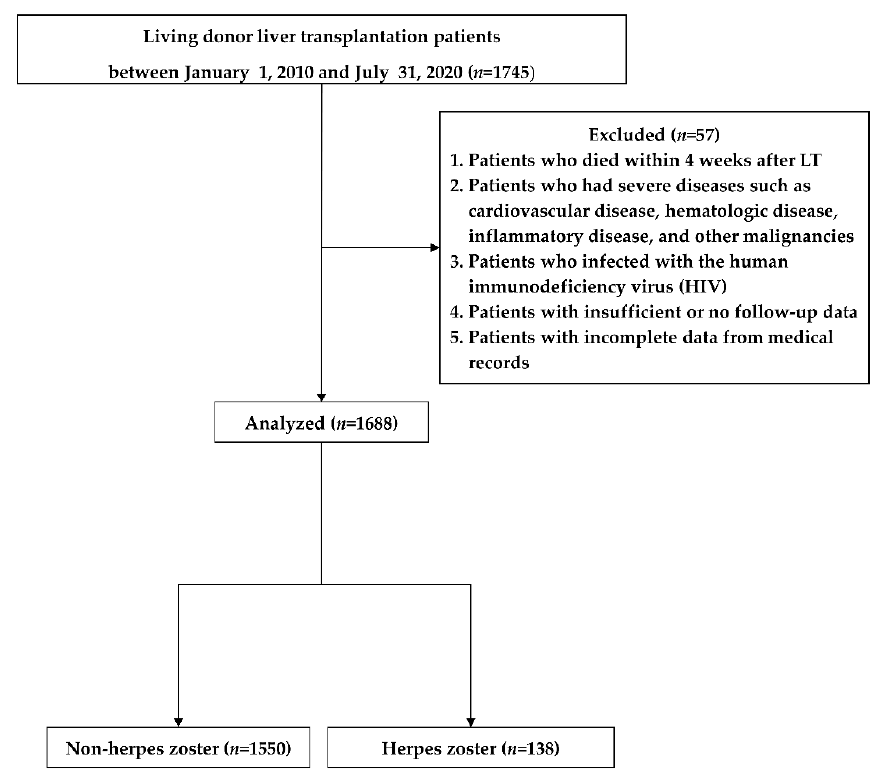
Figure 1. Flow chart of the study.